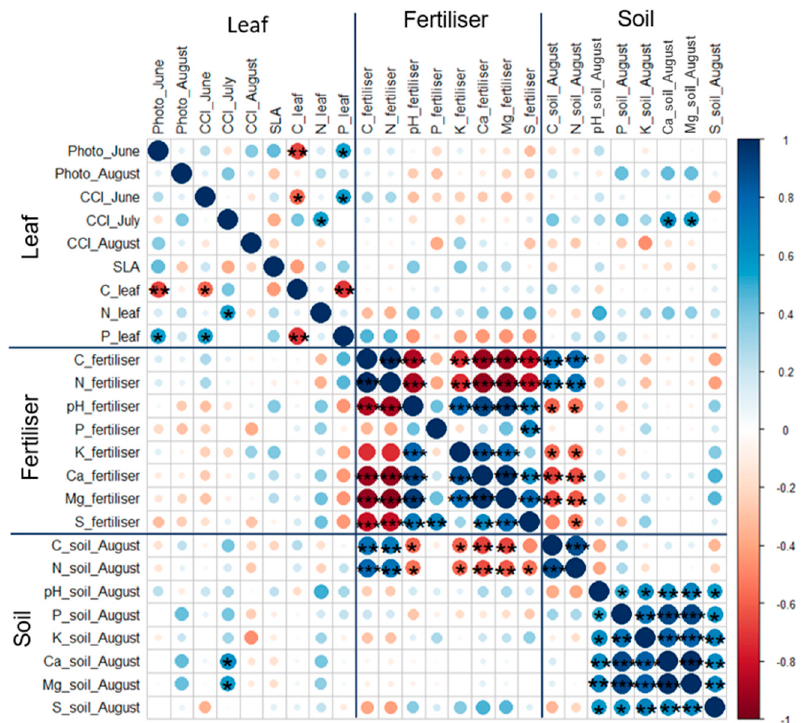
Figure 8. Correlation matrix, made using ‘corrplot’, between leaf physiological and morphological parameters and fertiliser and fertilised soil chemical composition in August (abbreviations: Photo—Photosynthetic rate ( µ mol m − 2 s − 1 ), CCI—Chlorophyll Content Index). Significance level: * p = 0.05–0.01, ** p = 0.01–0.001, *** p <